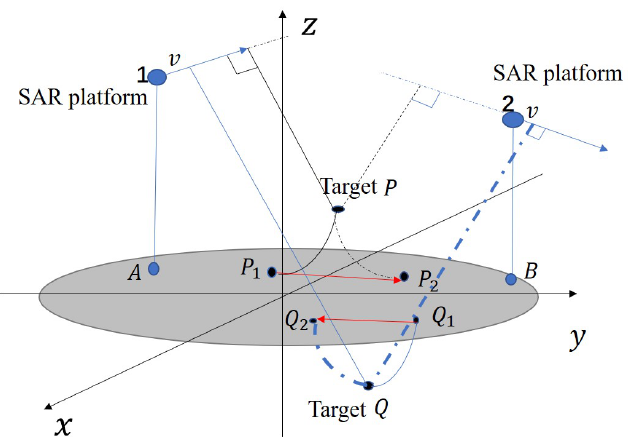
Figure 6. Discrimination of ±| ∆ h | .